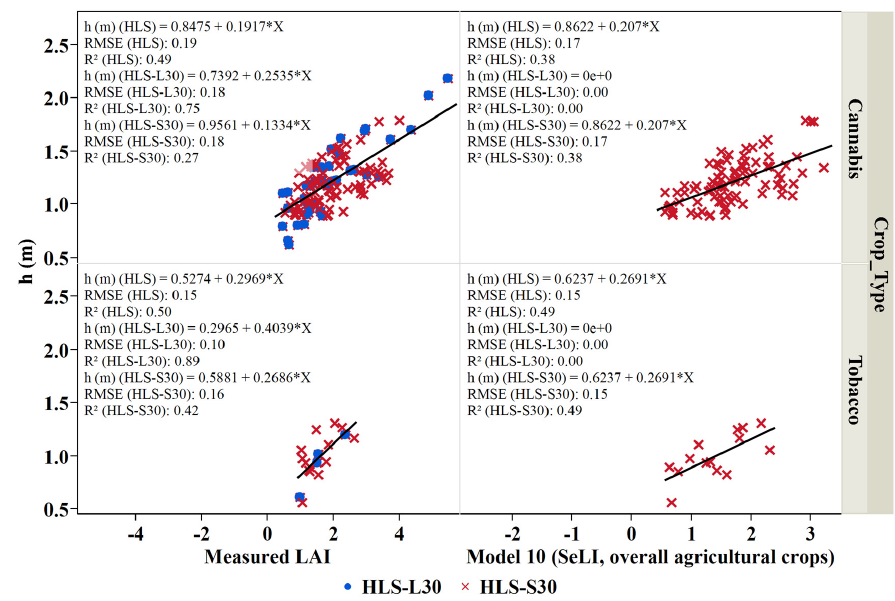
Figure 12 . Crop height (h (m)) as a function of measured LAI (m 2 /m 2 ) and LAI derived from Model 10 (SeLI, overall agricultural crops) for cannabis and tobacco crops studied during the 2018 growing season. Blue points represent the measurements during Landsat overpass and the red crosses represent the measurements during Sentinel 2 overpass.